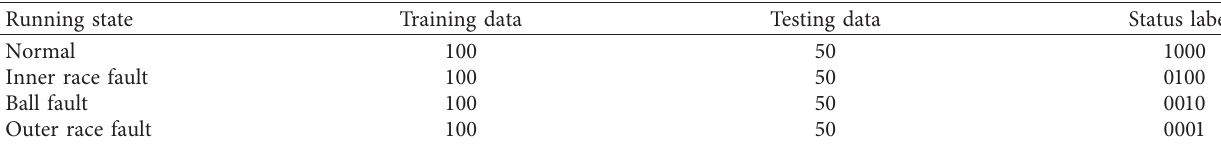
Table 2: Four operating states of rolling